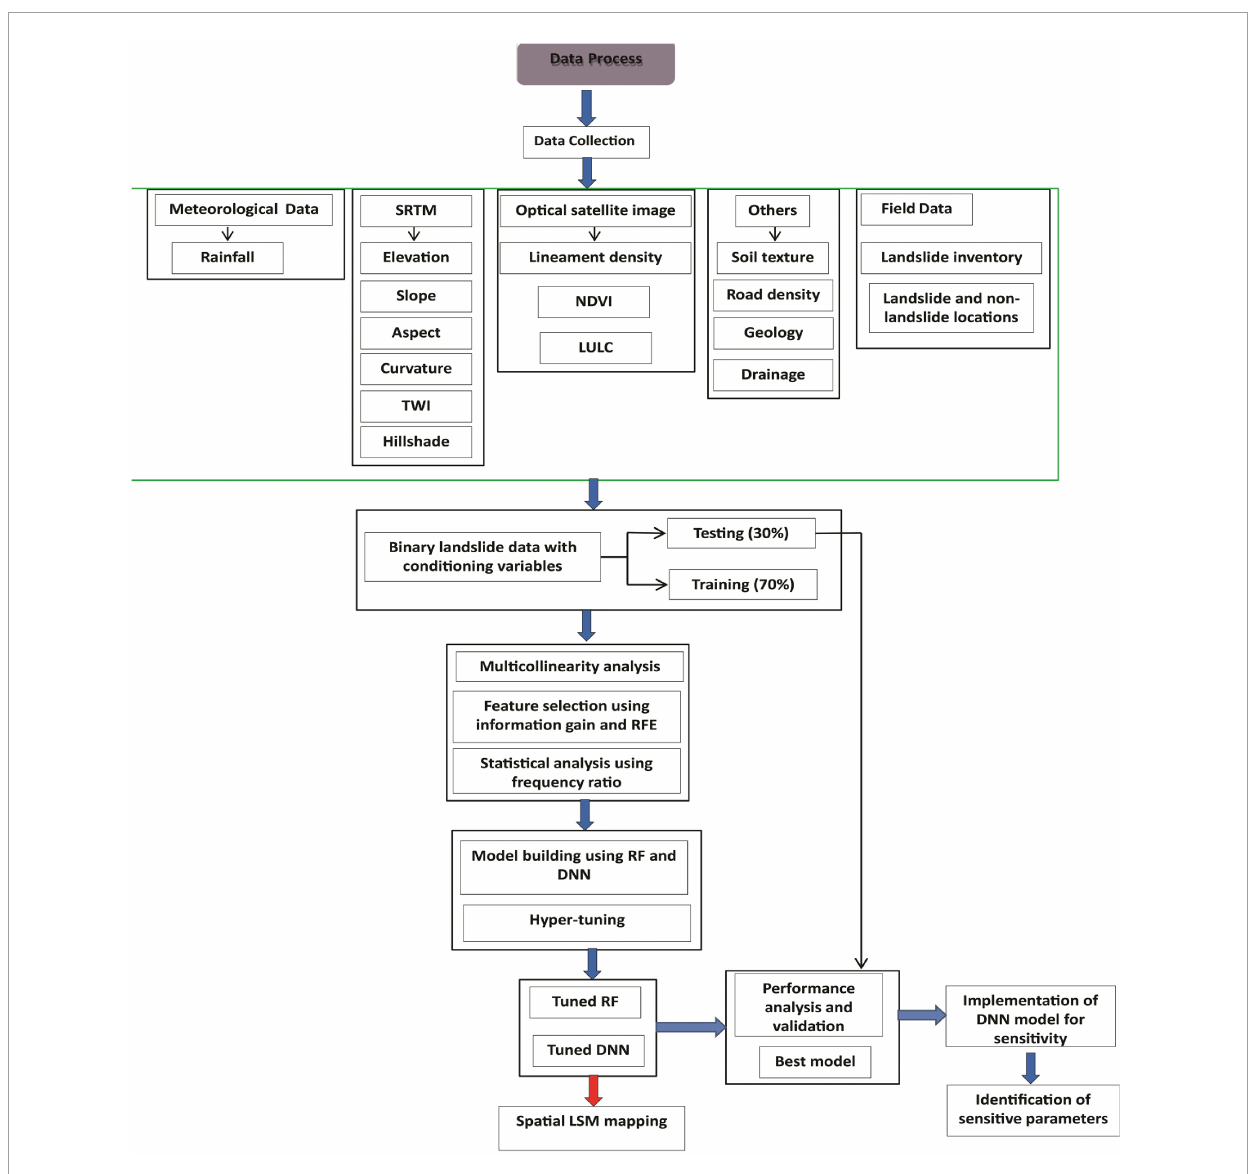
FIGURE3 Methodological hierarchy for employed methods in the study